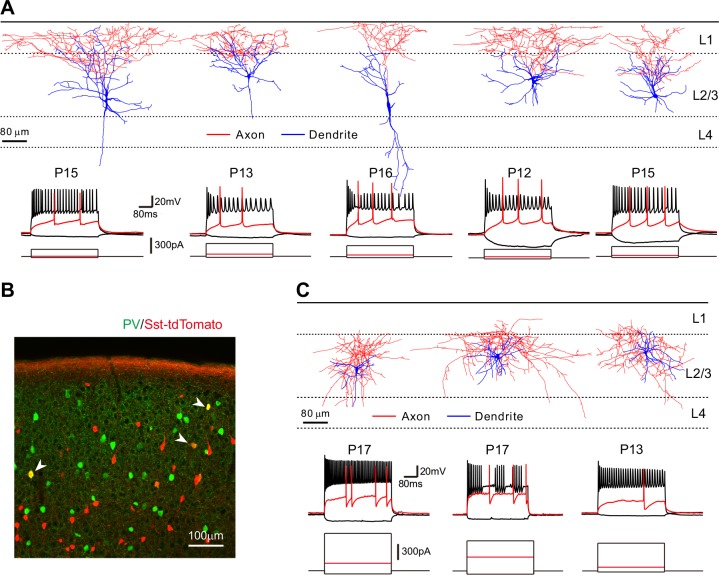
Morphological and electrophysiological properties of tdTomato+ neurons in Sst-tdTomato mice.(A) Top panel, the morphologies of reconstructed non-FS tdTomato+ neurons in layer 2/3 of visual cortex. Bottom panel, corresponding traces of voltage responses to 500 ms current pulse step injections recorded in the current-clamp mode. (B) Some tdTomato+ cells in Sst-tdTomato line expressed PV. Arrowheads indicated PV+/tdTomato+ cells. (C) Top panel, the morphologies of reconstructed fast-spiking tdTomato+ cells. These cells are basket-like interneurons, with dense axonal arborization in layer 2/3. Bottom panel, corresponding membrane voltage responses of cells to current injections.